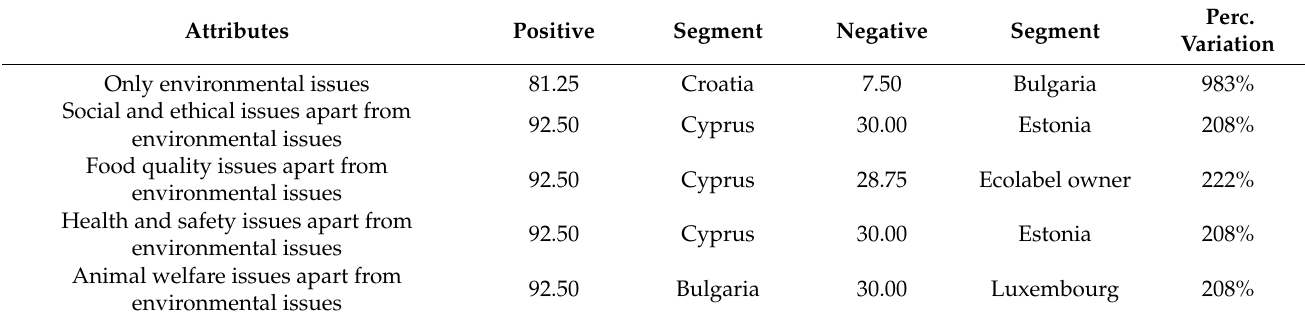
Table 6. Coverage of the EU ecolabels. Ideal